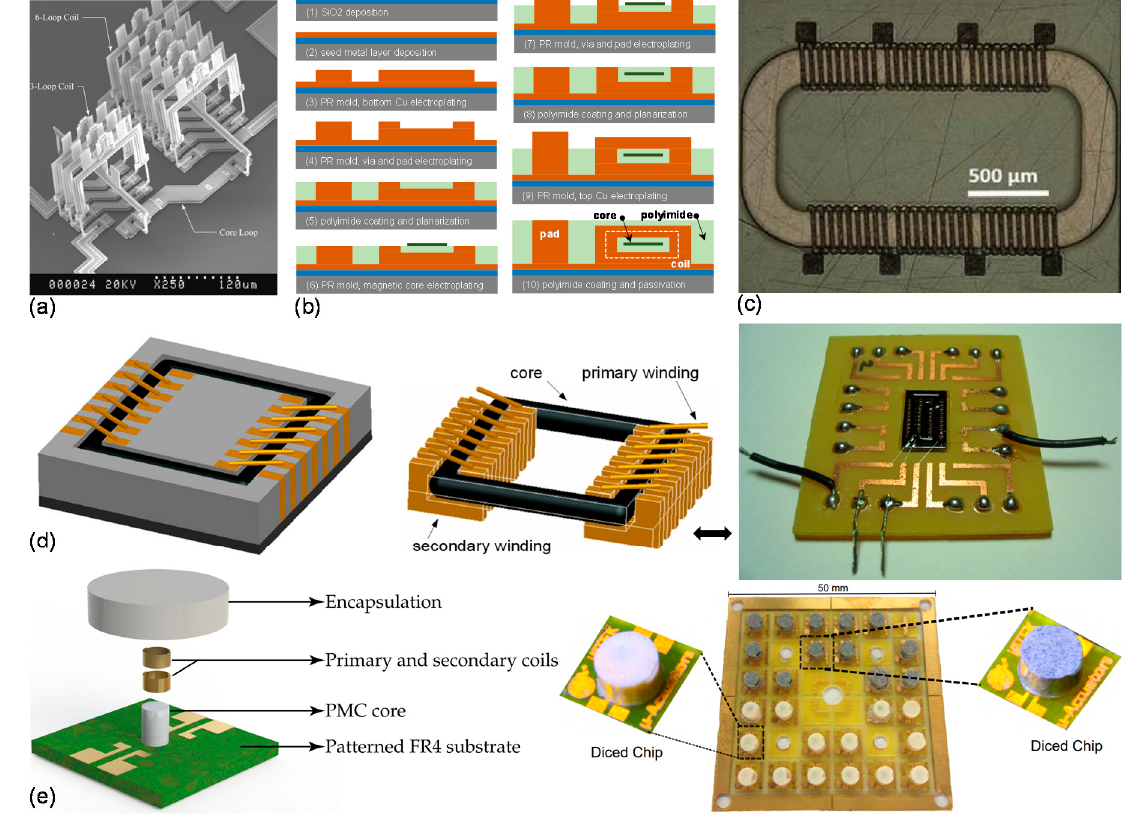
Figure 7. Various approaches to realize microscale transformers with integrated cores: ( a ) Micro-assembly using micro grippers, reprinted with permission from [86]; ( b ) thick resist and electroplating based process flow and ( c ) image of a fabricated transformer with a magnetic core, reprinted with permission from [87]; ( d ) ferrofluid-based core with microchannel [89]; ( e ) polymeric magnetic core using molding, casting and assembly [90].